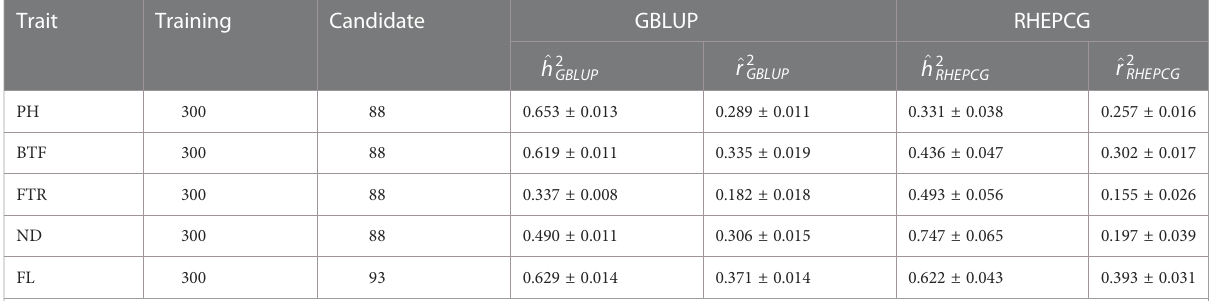
(Table 5). The estimated heritability of PH, BTF, FTR, and ND